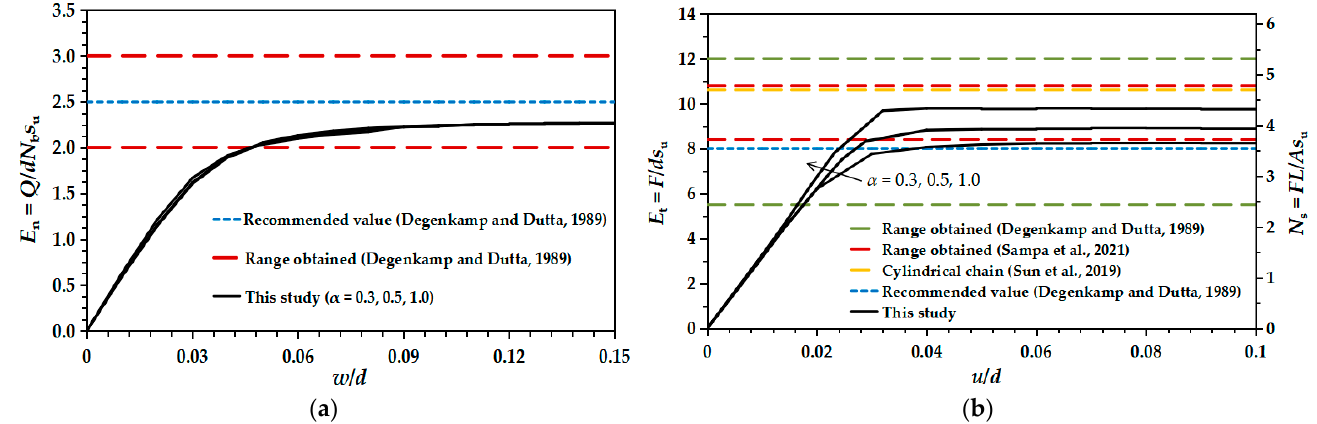
Figure 7. Comparison with the existing data of multiplier for effective width and uniaxial resistances: ( a ) multiplier for effective width in the normal E n ; ( b ) multiplier for effective width in the tangential direction ( E t ) and normalized tangential resistance ( N s ). Compared with